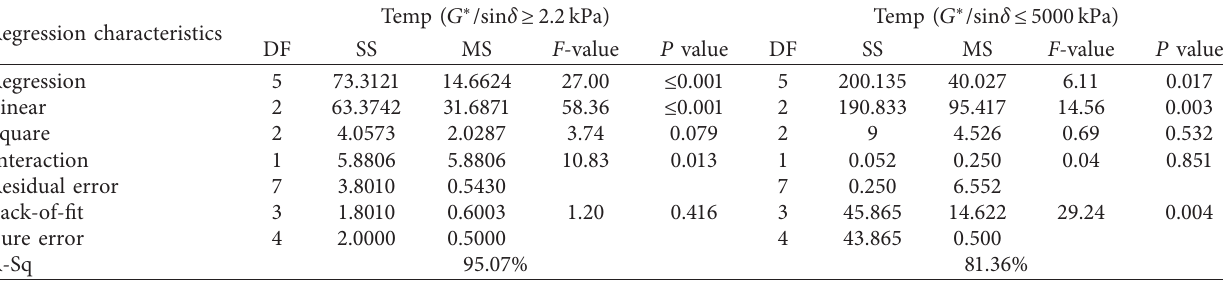
Table 5: ANOVA table for DSR